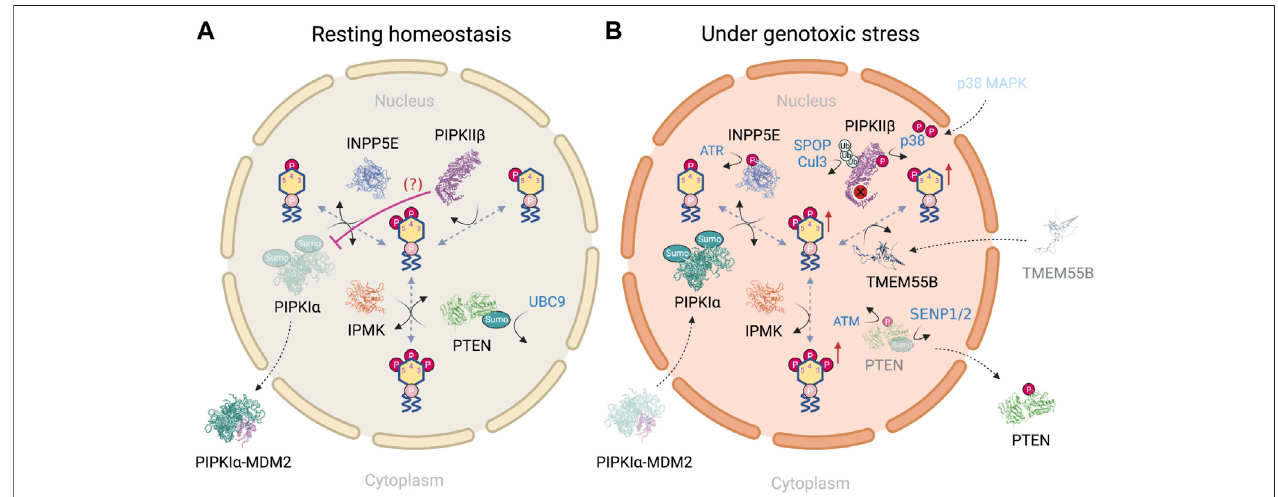
FIGURE 4 | (A) PI(4,5)P 2 -centric view of nuclear phosphoinositide homeostasis in a resting state and (B) how the regulatory steps are altered in response to genotoxic stress. Figures created with BioRender.com.